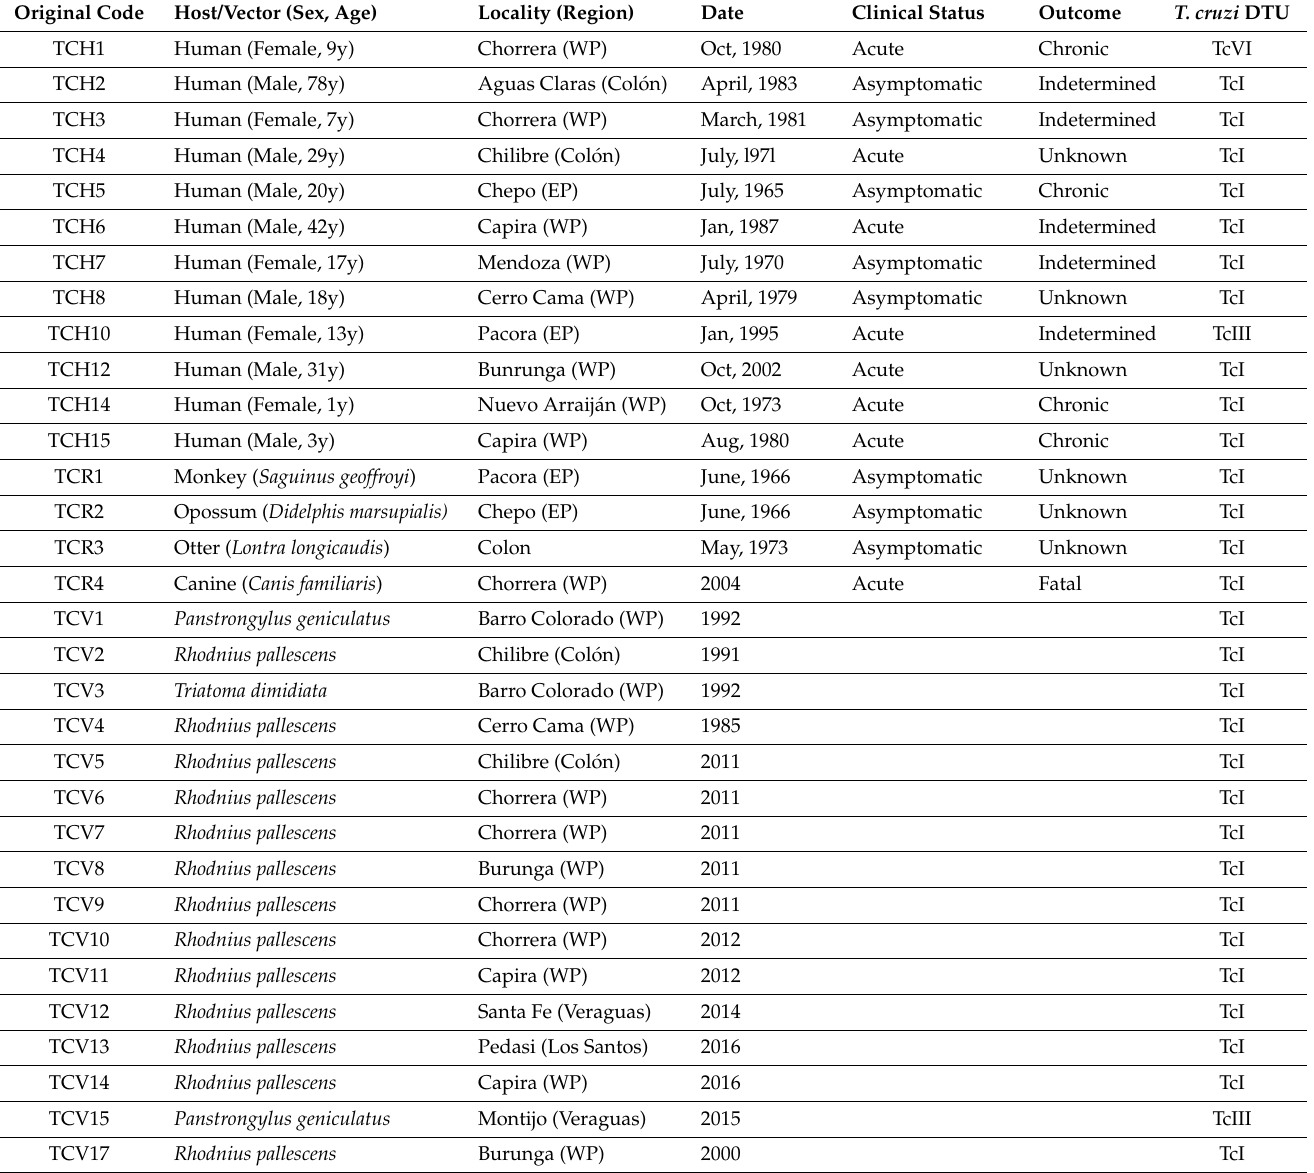
Table 1. List of Panamanian Trypanosoma cruzi isolates analyzed in this study with details about their epidemiological data, clinical history and results of discrete typing units